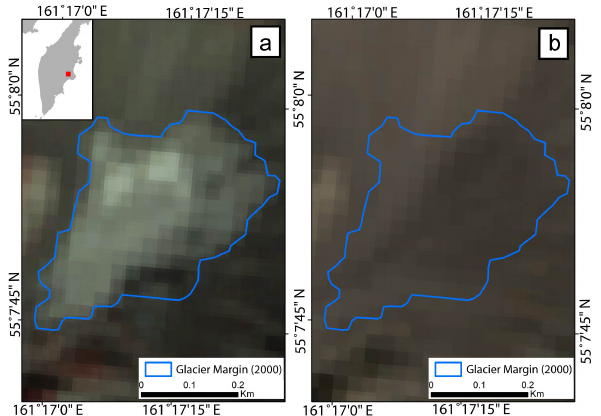
Figure 3. Example of a small glacier in the Vostocny Mountains that disappeared between 2000 (a) and 2014 (b) . In both (a) and (b) , the background is a Landsat